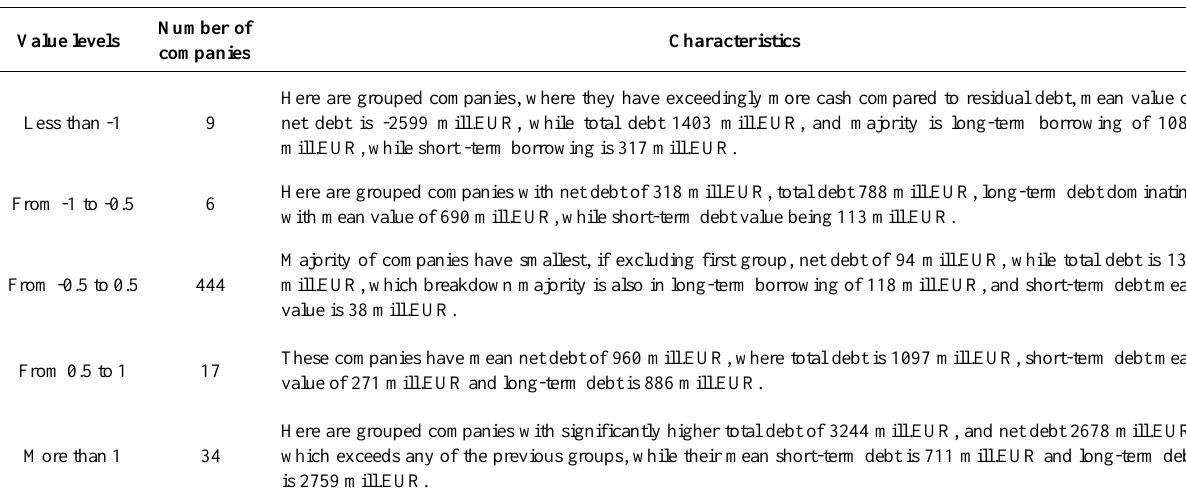
Table 6. Detailed characteristics of Complex factor 3 – debt